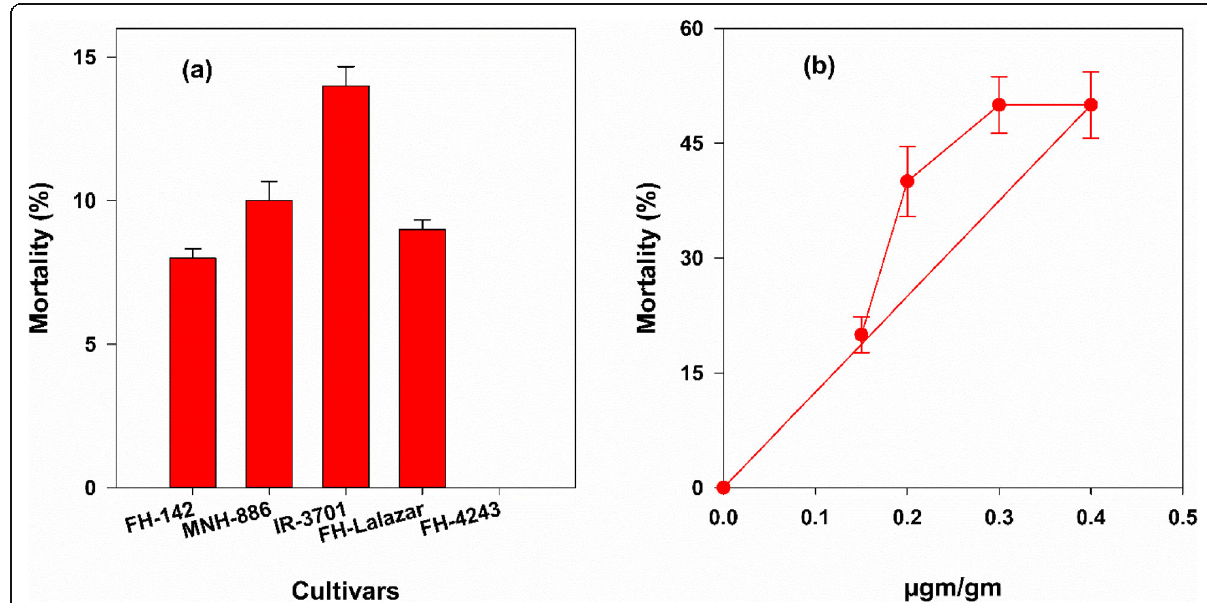
Fig. 3 a Mortality percentage of Helicoverpa armigera by feeding bolls of different cultivars after 90 days of infestation. b Scatter diagram indicating Cry1Ac concentrations inducing larval mortality of Helicoverpa armigera